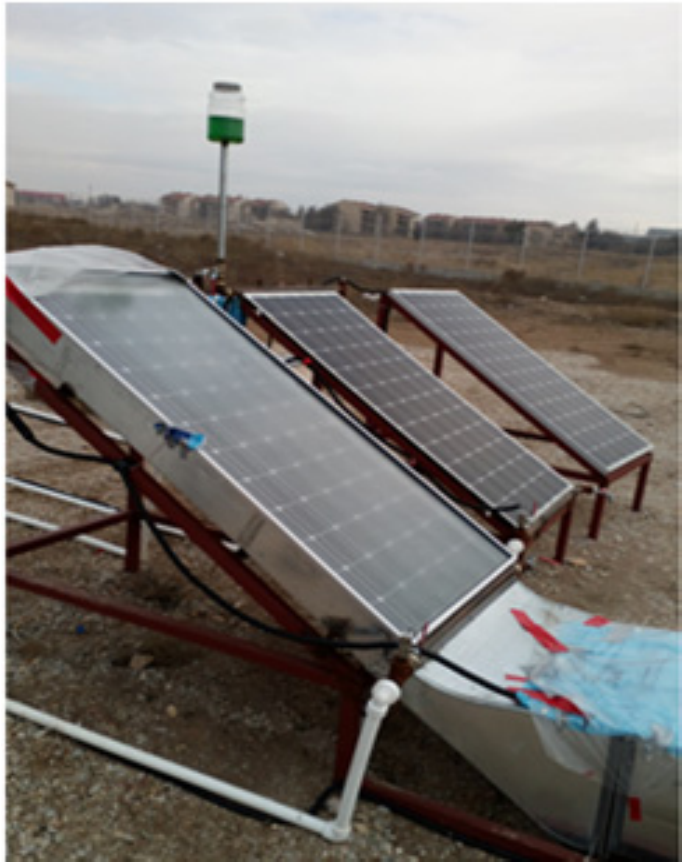
Figure 3. General view of experimental set up.